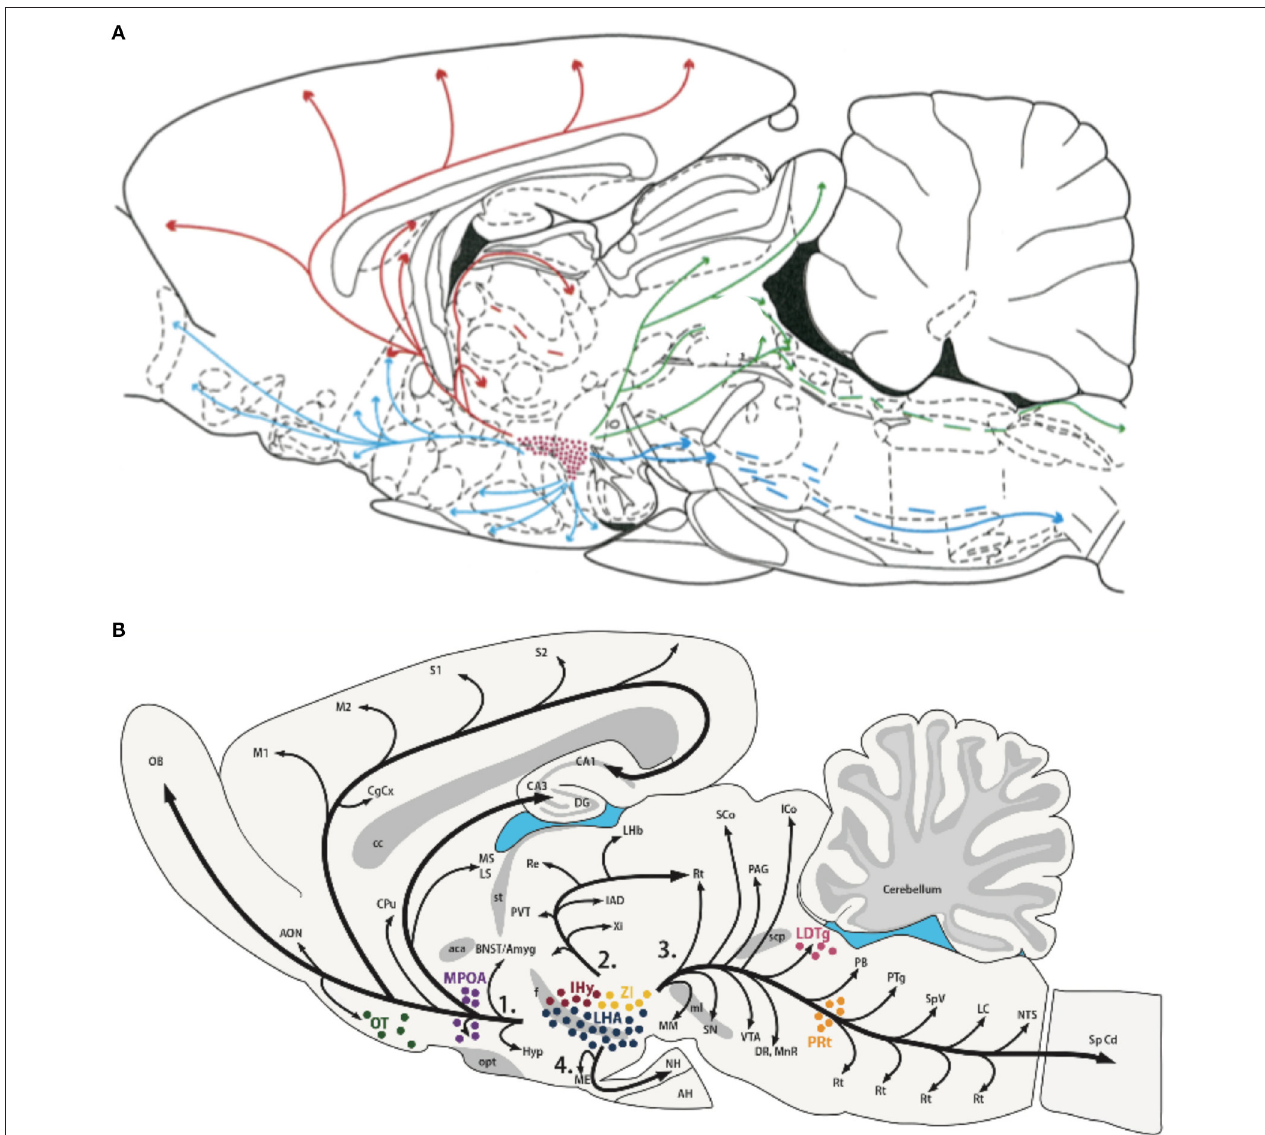
FIGURE 3 | Efferent projections of the hypocretin/orexin (Hcrt) (A) and melanin concentrating hormone (MCH) (B) systems. The extensive efferent projections from both the Hcrt and MCH neuronal populations originating from within the LH generally overlap and include similar target structures. The diversity of their projections, together with their reciprocal activity patterns and known opposing effects on target systems, is consistent with their hypothesized role in modulating global shifts in network activity and coordinating behavioral state transitions. Figures reprinted with permission (A) Peyron et al. (13), and (B) Diniz and Bittencourt (188). For abbreviations in (B) , see Diniz and Bittencourt